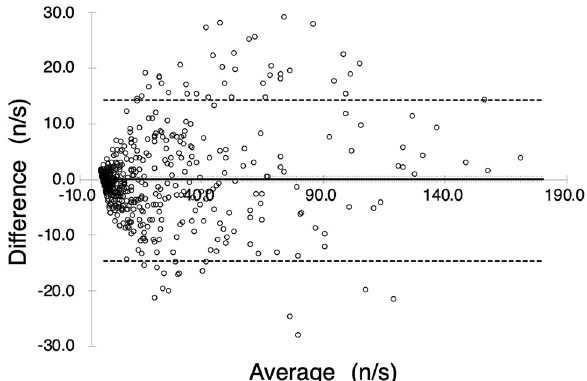
Figure 4. Bland–Altman plot comparing estimated and measured numbers of microbubbles. The solid line denotes the bias (mean of the difference), the large dashed line denotes the 95% limits of agreement (two standard deviations of difference), and the small dashed lines denote the 95% confidence interval for the difference between the means.